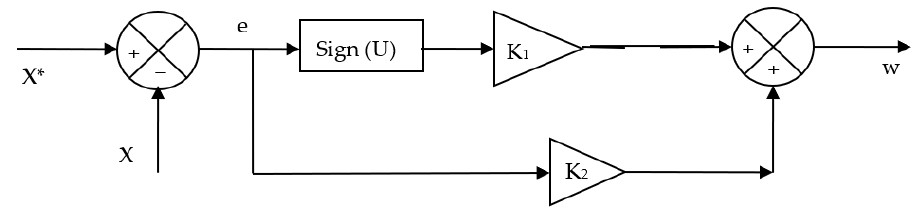
Figure 2. Schematic diagram of the proposed MSMC technique.